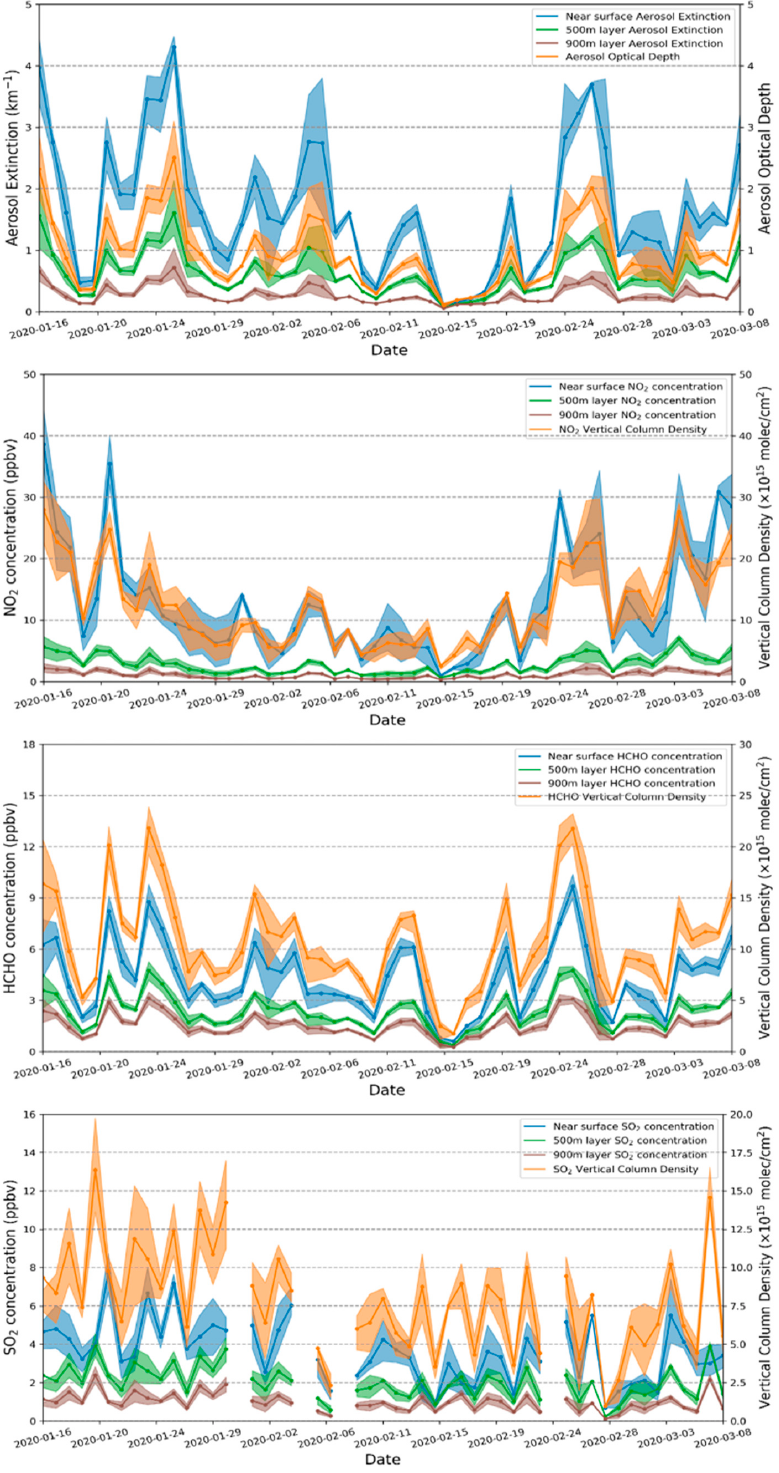
Figure 3. Daily time series of aerosol extinction, NO 2 , HCHO and SO 2 ; average of observed pollutants (dots) shown for 16 January 2020 to 8 March 2020. The shaded areas mark the 25th–75th percentile range.